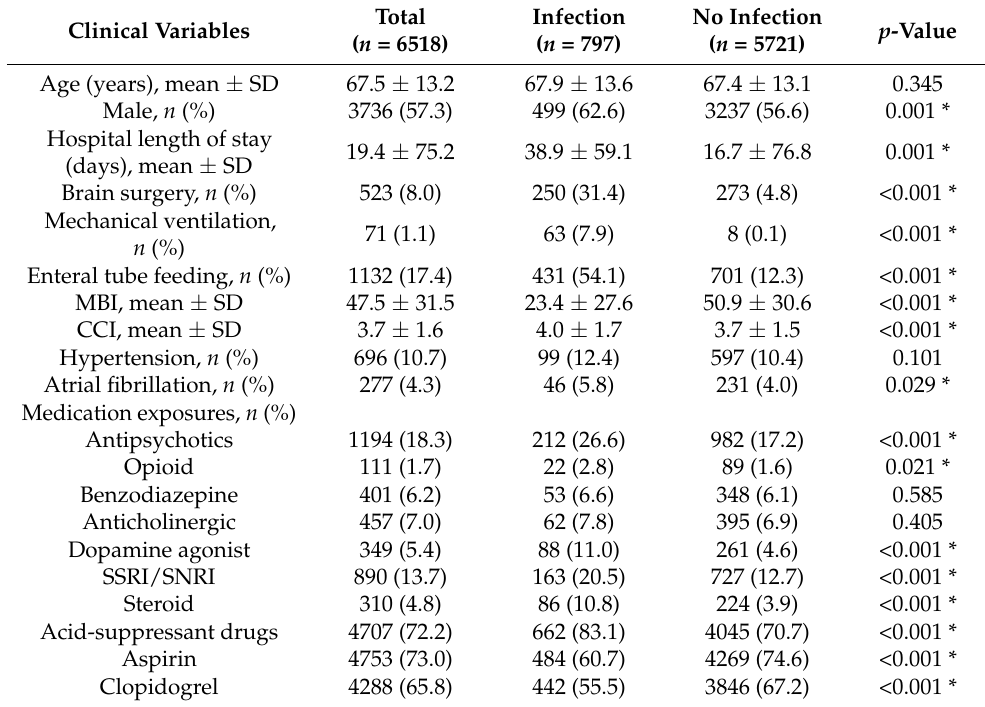
Table 1. Baseline characteristics of the study population.